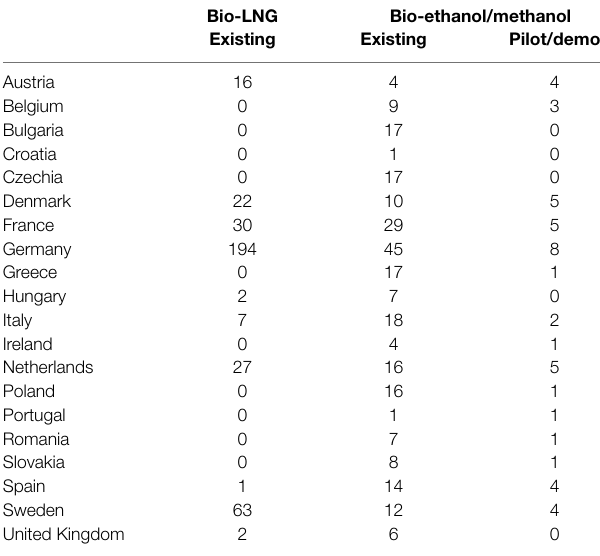
TABLE 3 | Overview of currently existing biomass refineries in Europe.